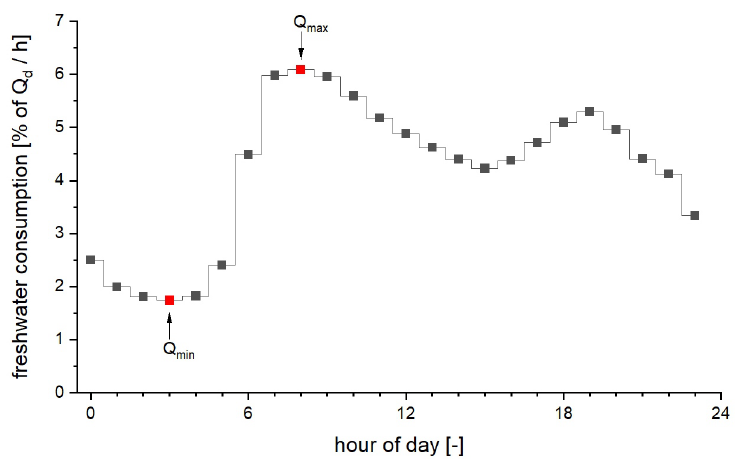
Figure 10. Diurnal pattern of freshwater consumption. Table 2. Hydraulic characteristics of the modelled sewer